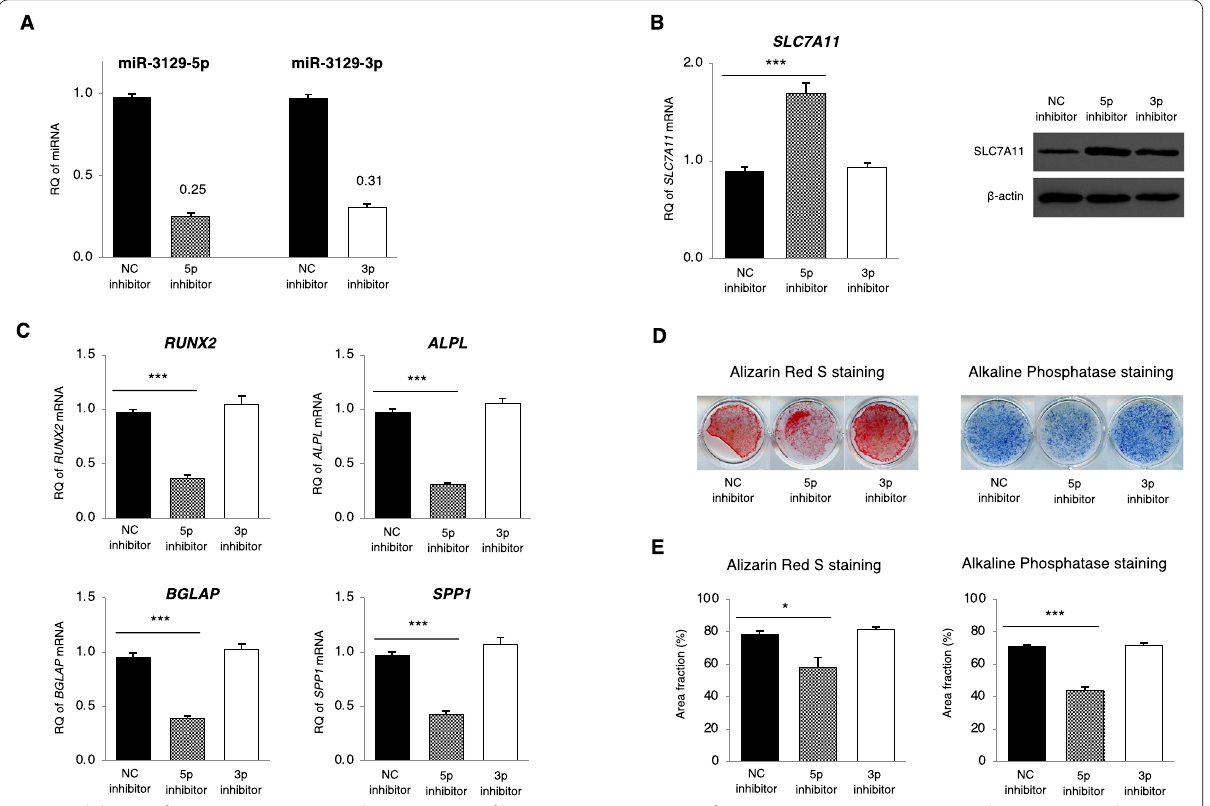
Fig. 6 Inhibition of miR‑3129‑5p attenuated osteogenesis of hBMSCs. A – C Expression of miR‑3129 ( A ), SLC7A11 mRNA and protein ( B ), and osteoblast markers ( C ) in MSCs at 48h ( A, B ) and day 18 ( C ) after transfection of miR‑3129‑5p and miR‑3129‑3p inhibitors. The levels of miRNA and mRNA expression were quantified by qPCR. The amounts of miRNA and mRNA transcripts were expressed relative to the amounts of U6sn and GAPDH transcripts, respectively. B The levels of SLC7A11 protein were detected by Western blotting. β‑actin was used as a loading control. The images cropped from the data ( n 1) on Fig. S4 are shown on the right side of Fig. 6B (see Additional file 7). D , E Alizarin Red S and = alkaline phosphatase staining were performed in three independent experiments on day 21 after transfection of miRNA inhibitors ( D ), followed by quantification with ImageJ software ( E ). Western blotting was performed one time ( n 1 in B ). Data are expressed as mean SD from = ± three independent experiments (each n 3 in A – H ). * p <0.05, *** p <0.001 vs. NC inhibitor by Student’s t ‑test. NC, negative control; RQ, relative =